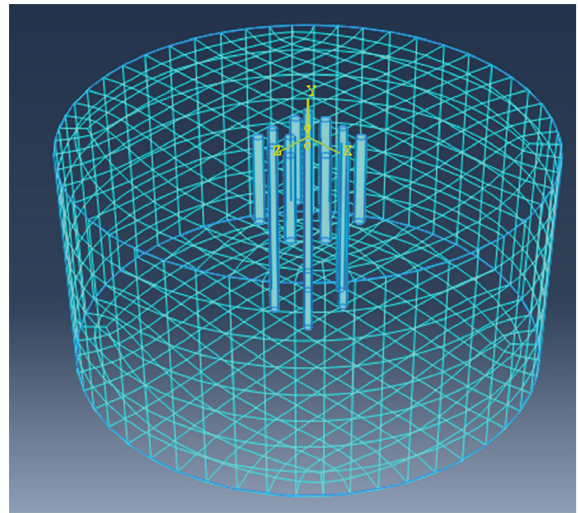
Figure 4: 3D finite element